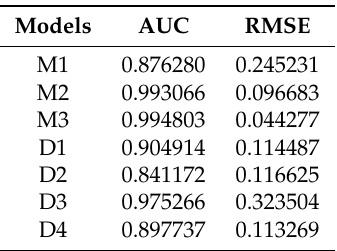
Table 2. Models’ performances on the test dataset with 181 variables using AUC and RMSE values for the seven